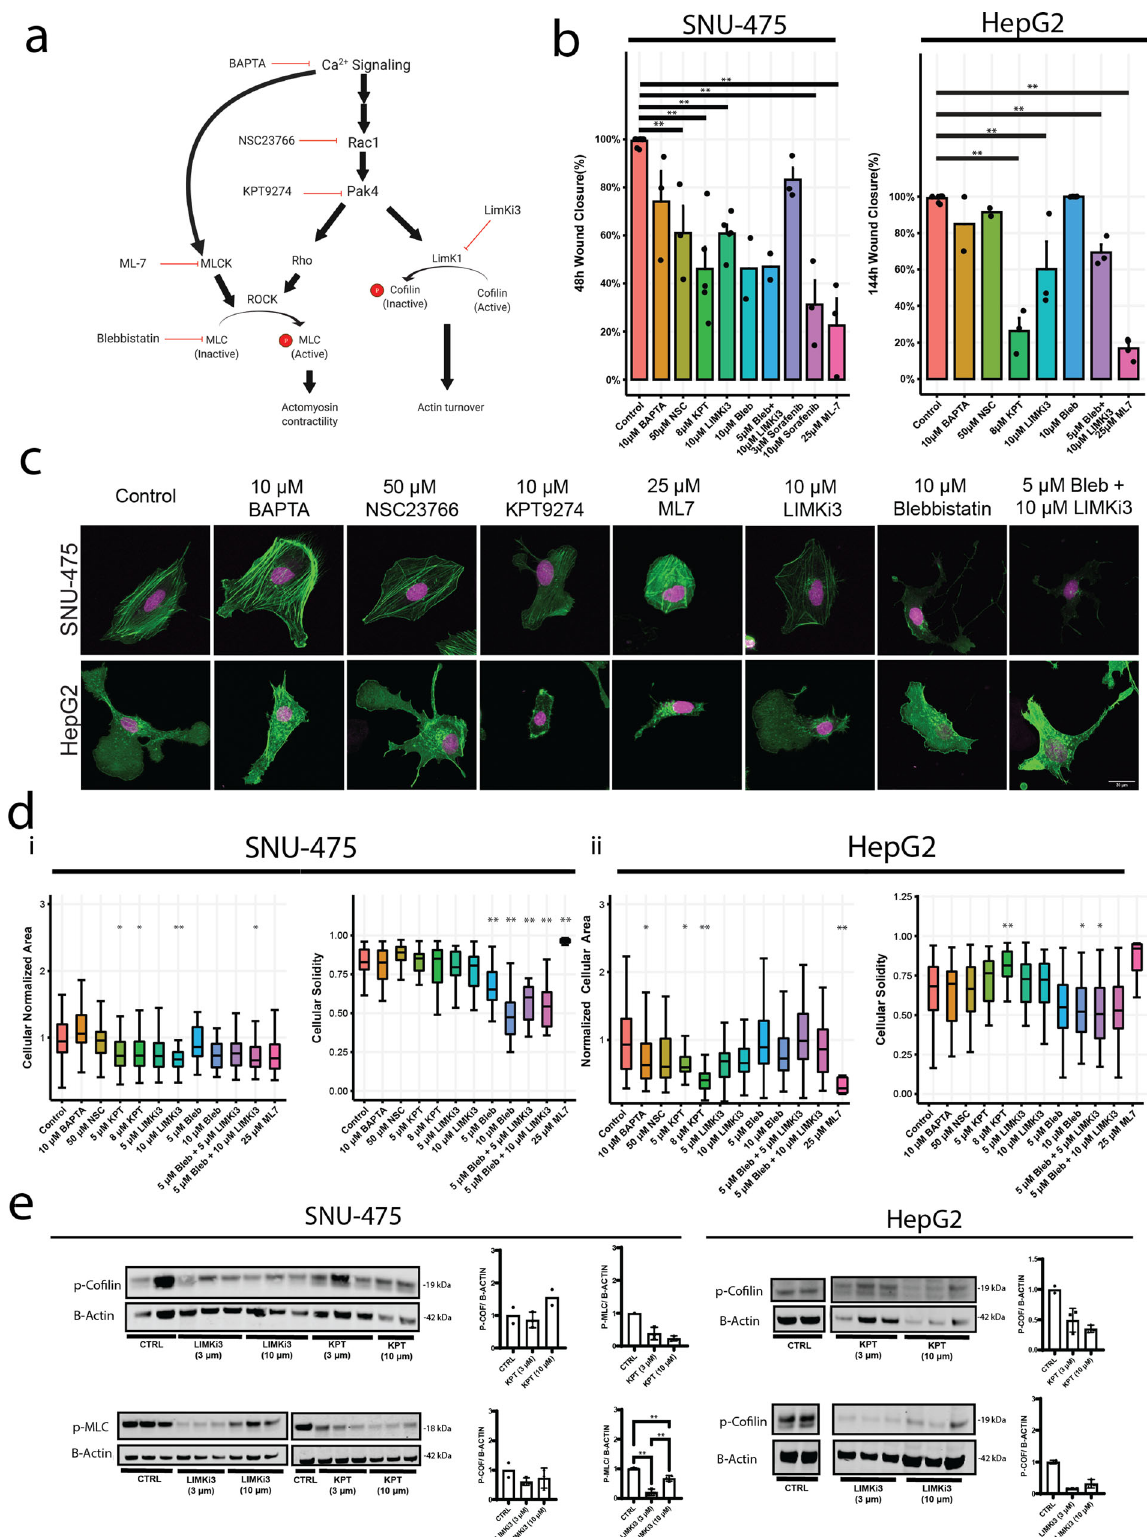
HepG2 spheroid core growth but did not signi fi cantly affect escape into the surrounding matrix (Fig. 5b). When examining the surrounding matrix, KPT9274 reduced short-range and long- range collagen densi fi cation by SNU-475 spheroids (Fig. 5c-e, Supplementary Fig. 11). This suggested that PAK4 plays a role in SNU-475 matrix densi fi cation and alignment as well as